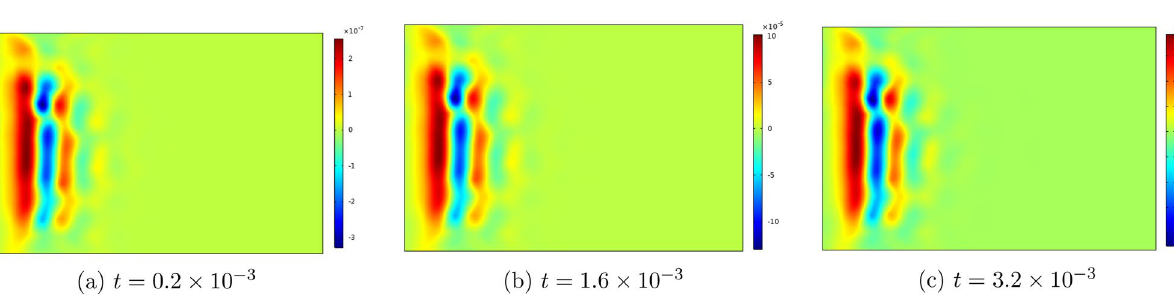
Figure 10. Top view of the distribution of σ xx in the slab at three consecutive time